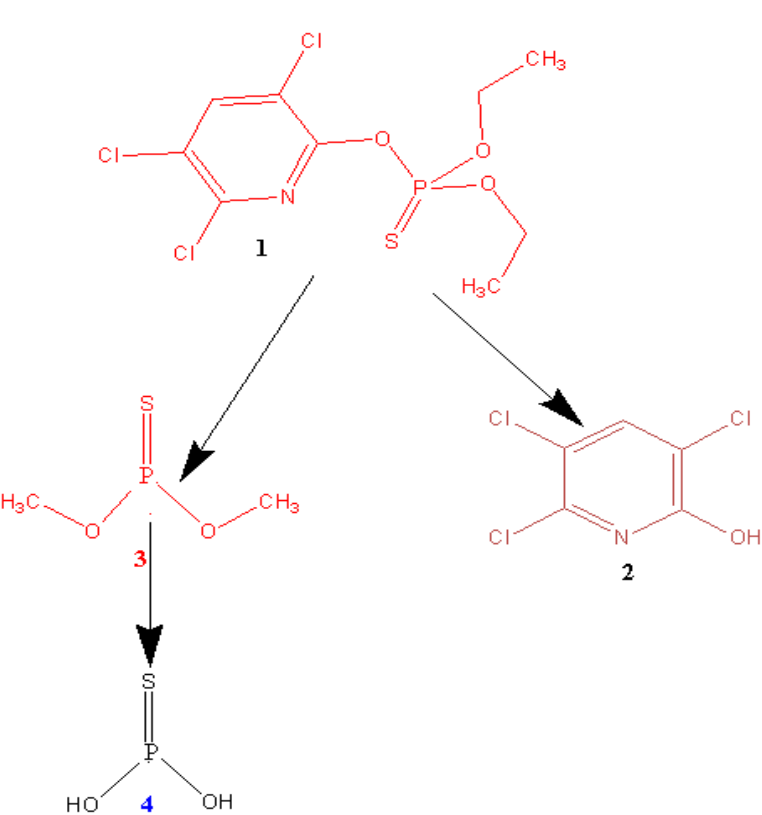
Figure 16. Proposed degradation pathway for chlorpyrifos.